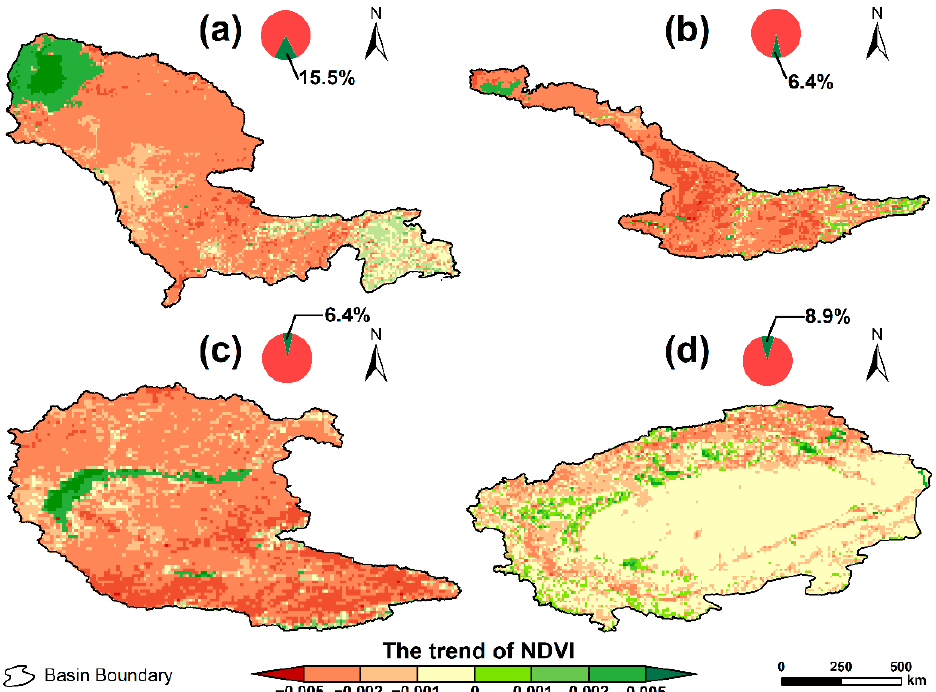
Figure 7. Spatial variation of annual NDVI in major basins in CA from 1982 to 2017. The pie chart shows the percentages of areas of NDVI decrease (red) and increase (green) relative to the entire basin. ( a ) ADB, Amu Darya Basin; ( b ) SDB, Syr Darya Basin; ( c ) IRB, Ili River Basin and ( d ) TRB, Tarim River Basin.